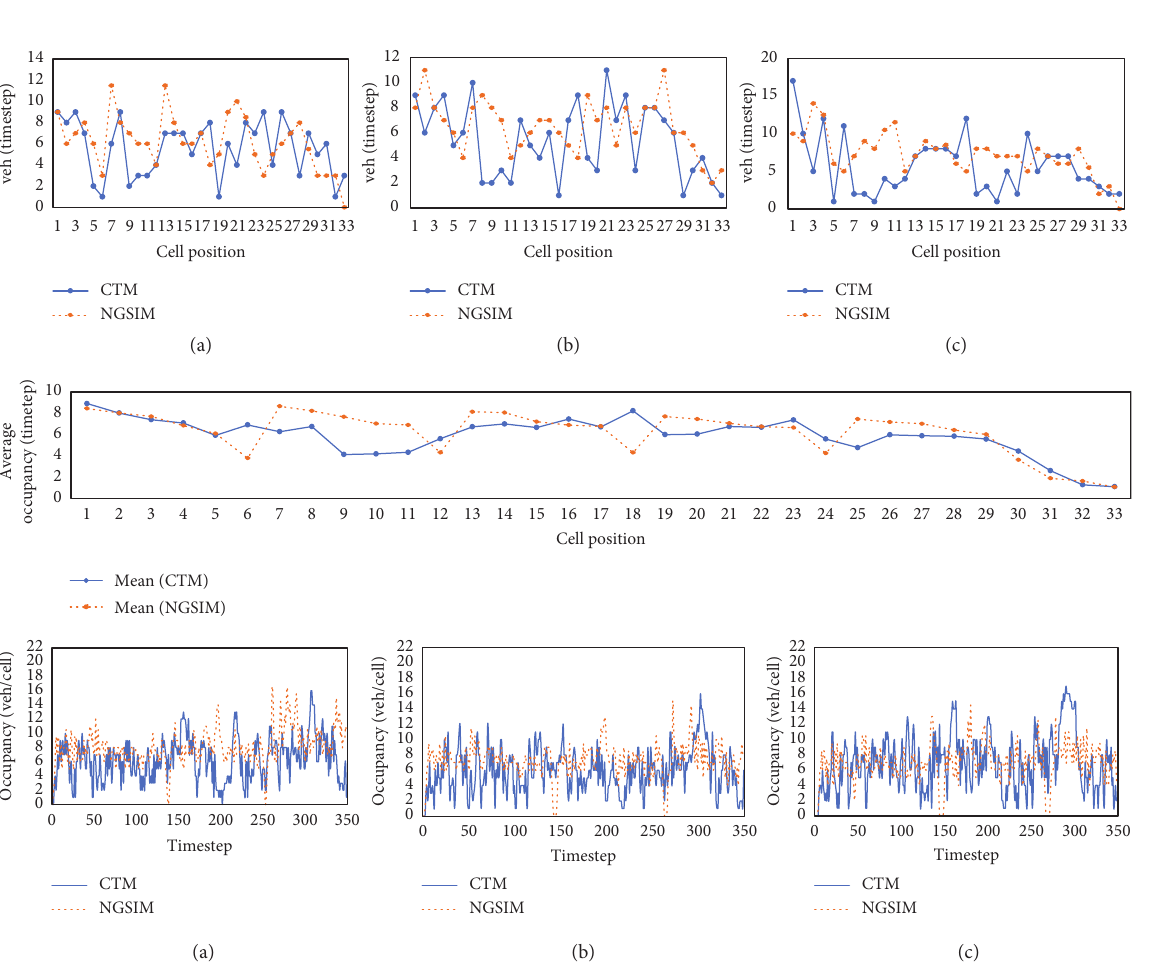
Figure 17: Validation of CTM with US-101 for case 23. (a) C2L3, (b) C3L3, and (c) C4L3. Table 4: Lane and cell position of US-101 highway